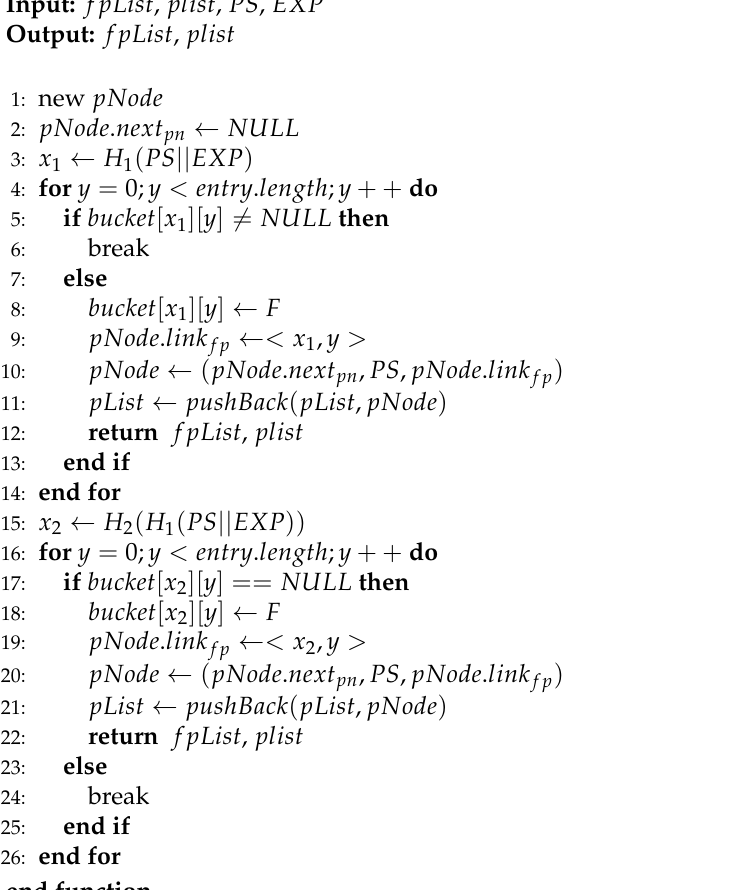
Algorithm 3 InsertFP